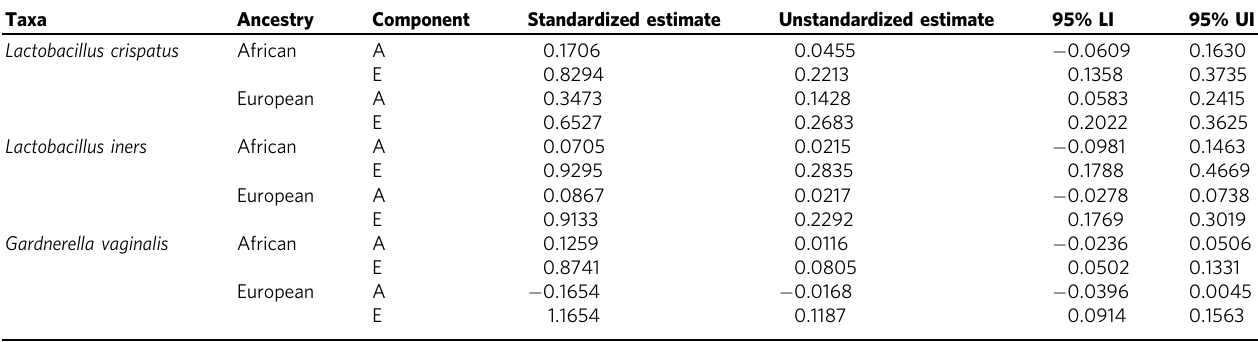
Table 2 Heritability estimates for predominant taxa by self-reported